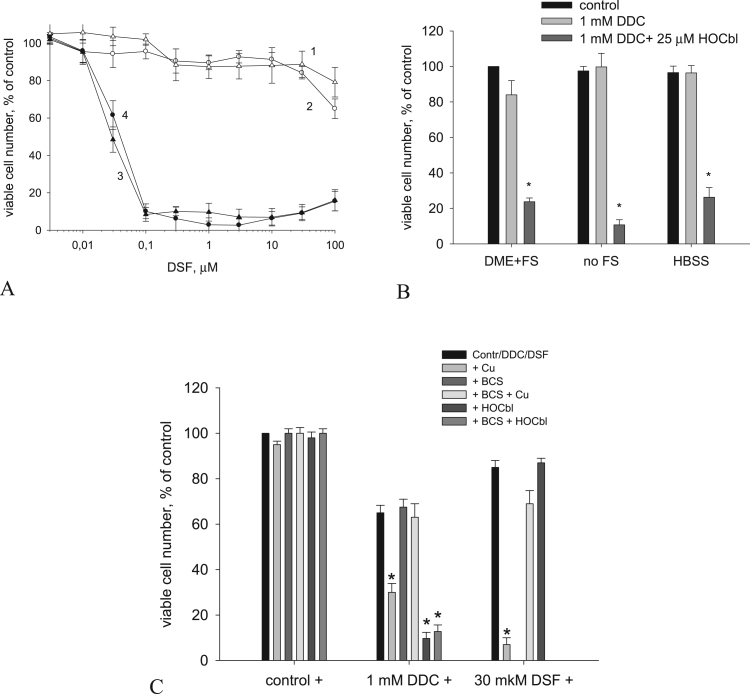
Cytotoxic effect of the products of the reaction of DDC + HOCbl in А549 cells. (А) Viability of А549 cells in the presence of the precipitate obtained in an aqueous solution of 10 mM DDC and 250 μM HOCbl (1) and of commercial DSF (2) in А549 cells without the addition of copper ions and after the addition of 4 μM CuSO4 (3, 4, respectively). (В) Cytotoxicity of DDC + HOCbl in Cu-free and Cu-containing media. Incubation time: 3 h with serum-free DMEM and 6–7 h with DMEM + FS and HBSS. Then, incubation media were replaced by a fresh growth medium DMEM supplemented with 10% FS. The cytotoxic effect was estimated 48 h after the addition of DDC + HOCbl. (С) Comparison of the effect of the chelator of extracellular copper BCS on the cytotoxic effect of 1 mM DDC + 25 μM HOCbl and on the toxicity of 1 mM DDC/30 μM DSF + Cu2+ (4 μМ) in DMEM + FS. BCS (50 μM) was added 1 h prior to the addition of DDC + HOCbl and DDC/DSF + Cu2+. The cytotoxicity was estimated at 48 h after the addition of the components (see Materials and methods). The data are the means ± SEM of five separate experiments. *P < 0.01 compared to cells treated with 1 mM DDC or 30 mkM DSF.